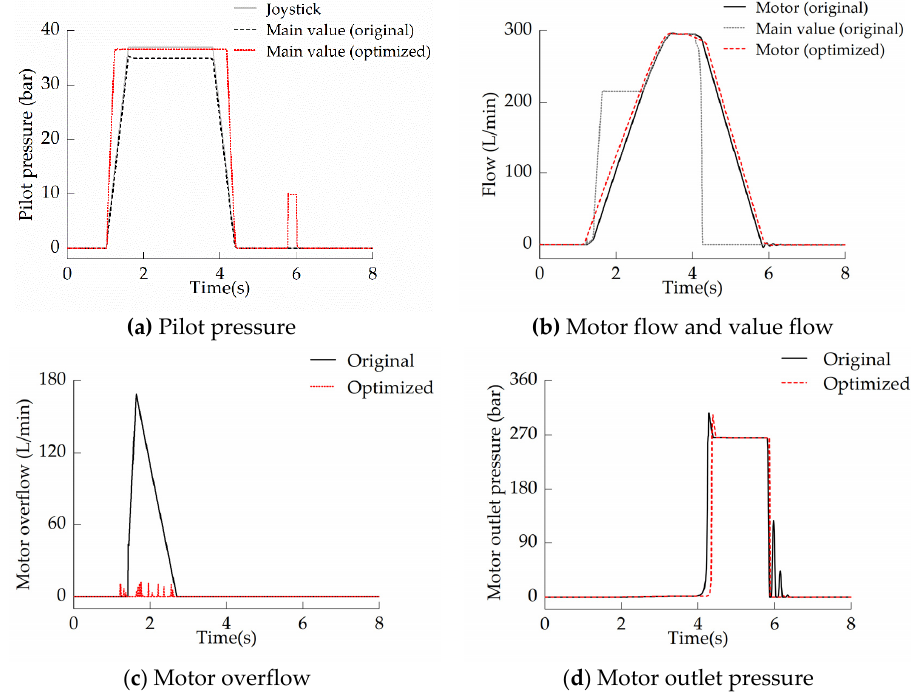
Figure 9. Operational characteristics of swing system (single-swing).